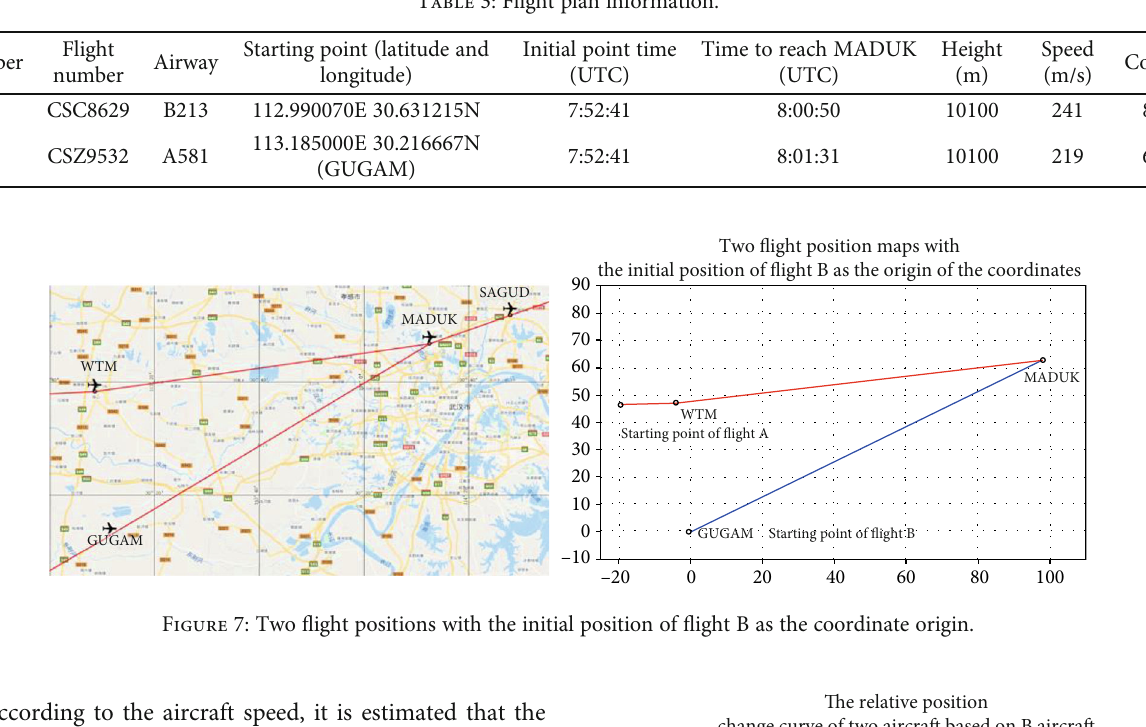
The relative position change curve of two aircraft based on B aircraft